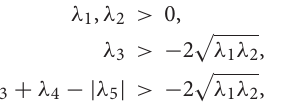
FIGURE 7 | Values of m h and m h in the DM phase. All points obey λ < 0.067 and β λ , δ , d Light Heavy (A) Red points obey the more restrictive condition β λ < 0.00005. (B) Red points obey β λ < 0.0005, β δ < 0.0025 and β d McDowall and Miller